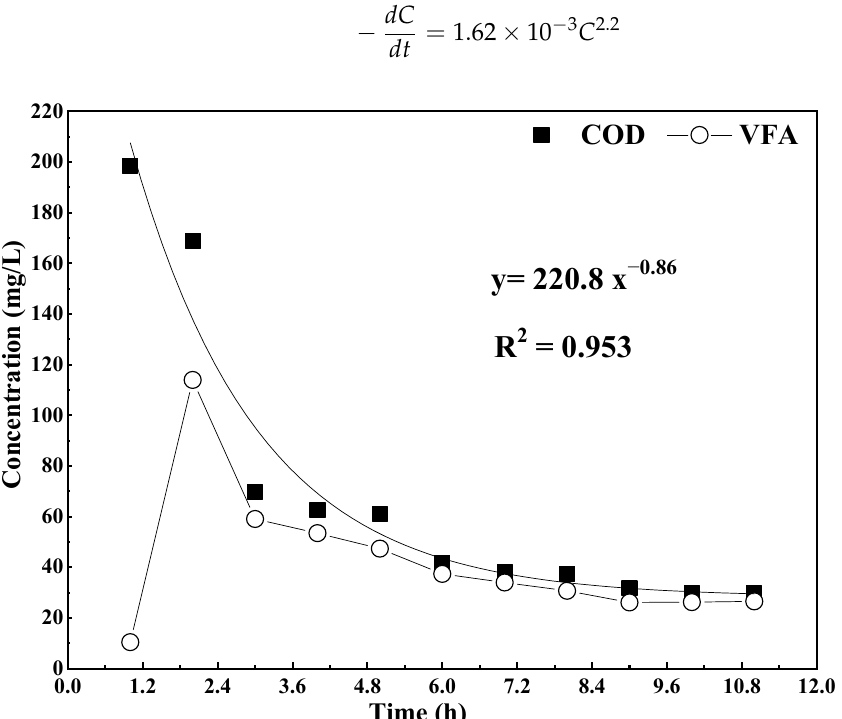
Figure 3. The concentration profiles of COD and VFAs in one ASBR cycle.